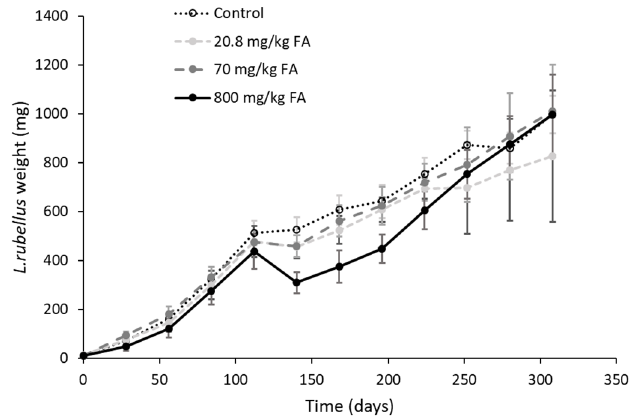
Figure 4. Mean ± SD weights (mg) of L. rubellus exposed to a control and three concentrations of fluoranthene from a young juvenile stage throughout development for 308 days.